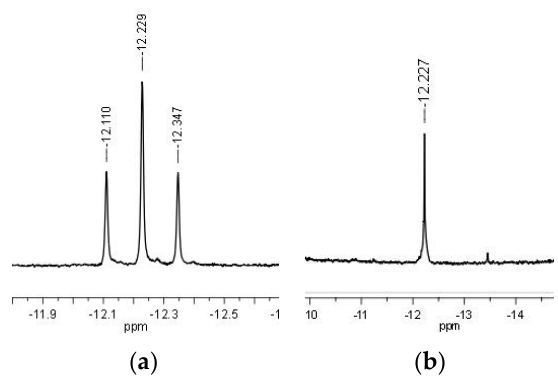
Figure 3. 1 H ( a ) and 1 H { 31 P} NMR ( b ) spectra (negative region only, CD 2 Cl 2 ) showing the change from triplet to singlet for the Ru-H signal in 4 .